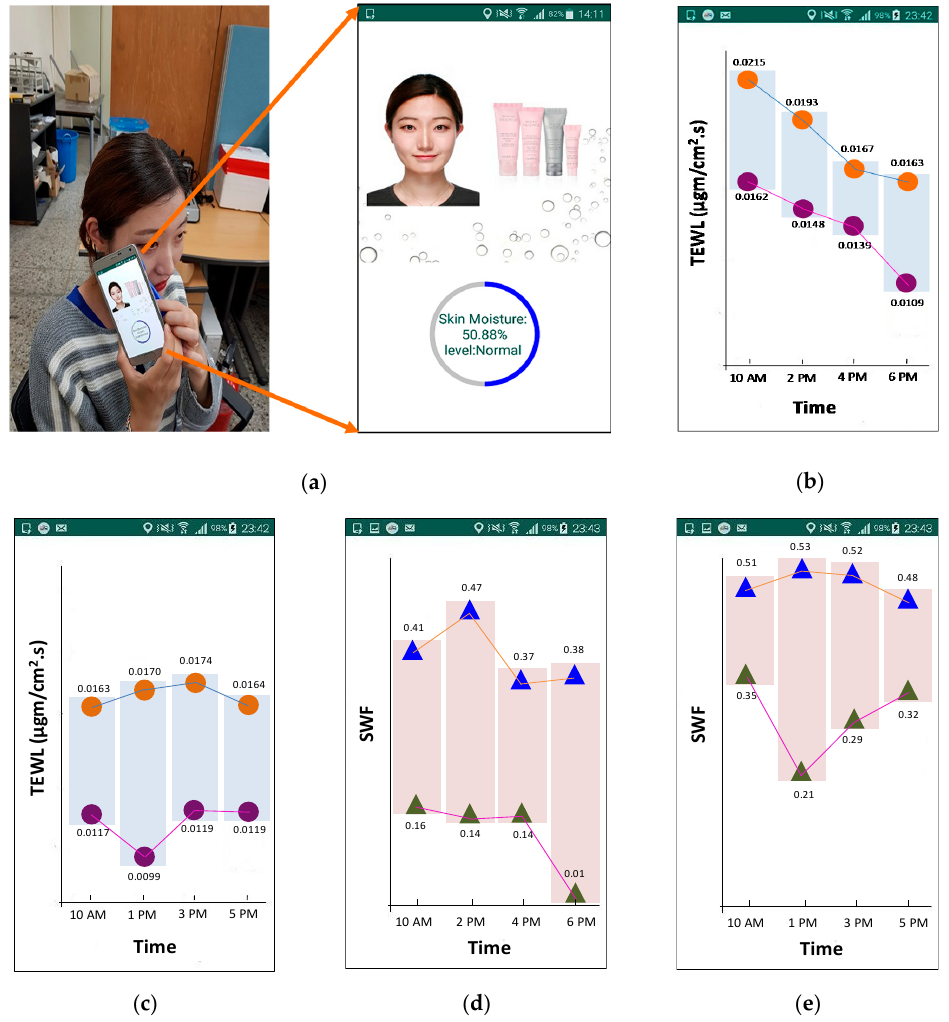
Figure 6. Android app used in combination with the smart skincare sensor device tag: ( a ) measurement of the skin moisture through a battery-free NFC approach; ( b ) waterfall graph with a trendline illustrating the TEWL result on the inside environment of eight subjects; ( c ) waterfall graph with a trendline illustrating the TEWL result on the outside environment of six subjects; ( d ) waterfall graph with a trendline illustrating the SWF result on the inside environment of eight subjects; and ( e ) waterfall graph with a trendline illustrating the SWF result on the outside environment of six subjects.